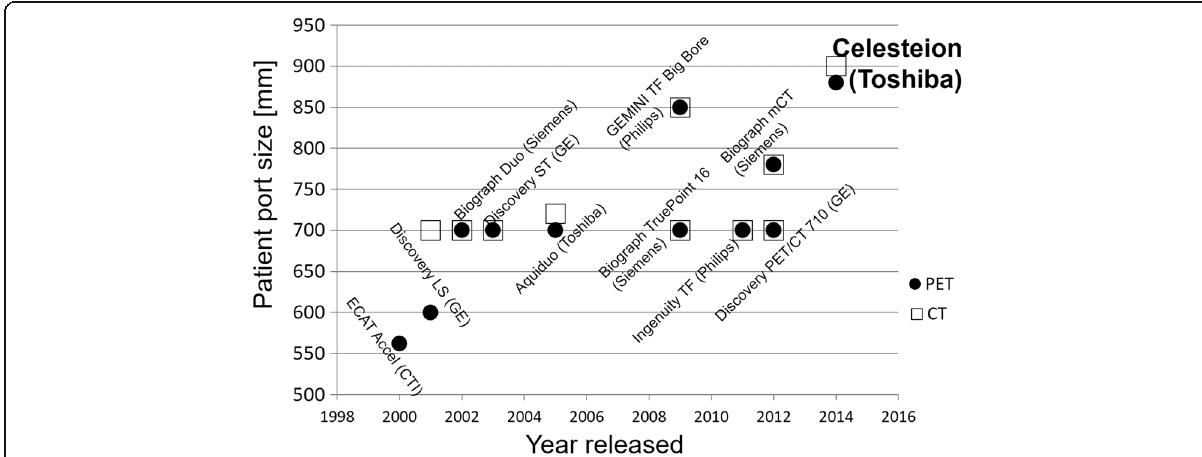
Fig. 1 The size of the gantry opening for the CT and PET components. Adjacent black circles and squares correspond to the same scanner. Notice that the left-most black circle represents a dedicated PET scanner, not a PET/CT scanner. Data was obtained from Imaging Technology News